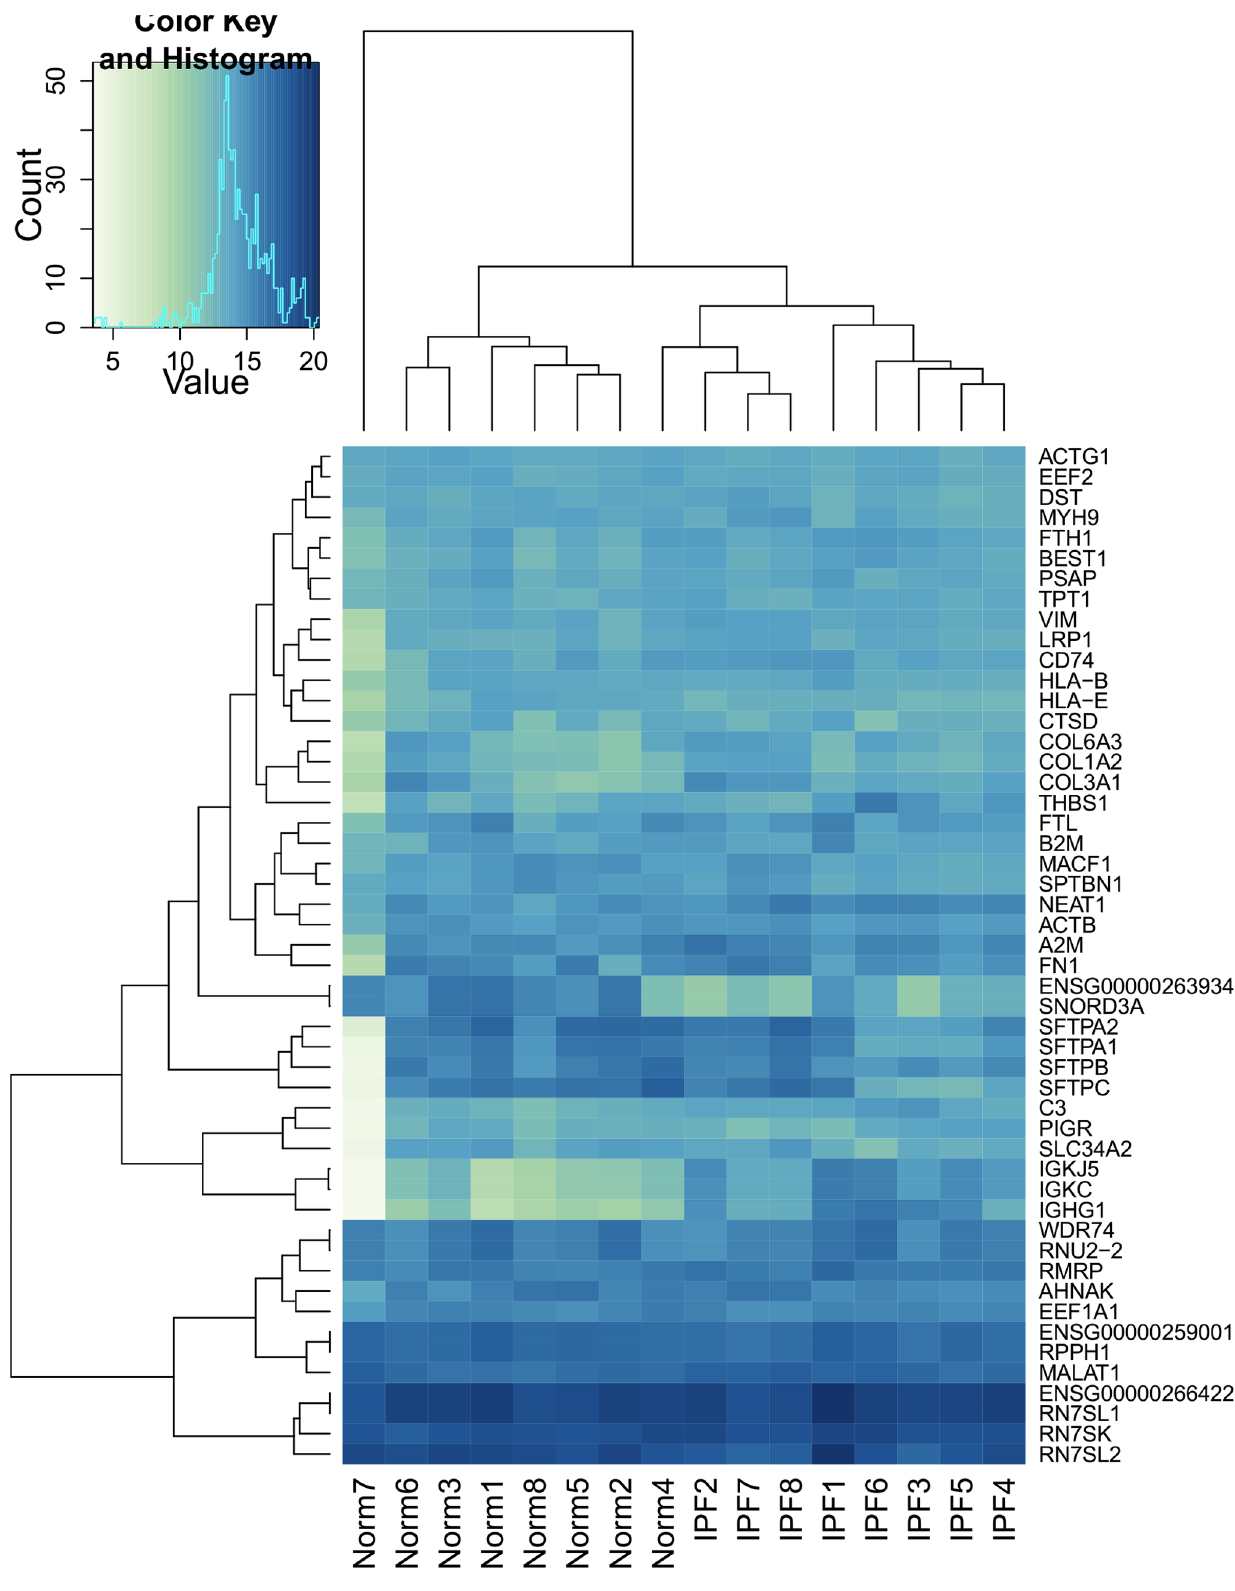
Figure 12. Norm 7 is an outlier in gene expression. This heatmap shows the top 50 most highly expressed genes (average across all samples) and corresponding hierarchical clustering of samples.